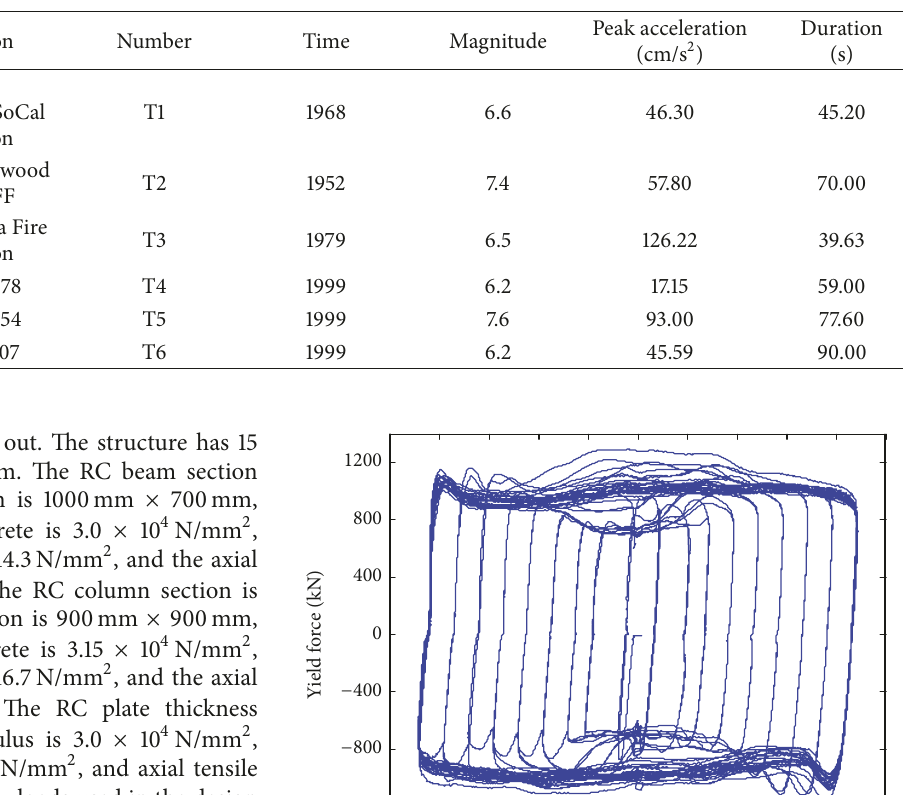
Table 1: Information of recorded ground motions.